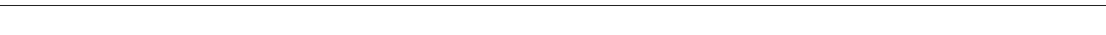
Fig. 3 MYC induces an alternative epigenetic program in mammary epithelial cells. a Barplot showing the distribution of MYC peaks on indicated genomic features in IMEC WT, IMEC-MYC, and M2. b Heatmap showing the dynamic behavior of MYC normalized ChIP-seq signals on MYC-bound TSS. Expression of annotated genes is reported. RPM reads per million. c Tag density plots of MYC normalized ChIP-seq signals in IMEC WT, IMEC-MYC, and M2, centered on up- (left) and downregulated (right) TSS. RPM reads per million. d GO of up- (upper panel) and downregulated (lower panel) genes bound by MYC on their TSS. e Identi fi cation of modulated enhancers among IMEC WT, IMEC-MYC, and M2. In the upper panel, the Venn diagram shows the overlap of H3K4me1 ChIP-seq peaks among different cell types. In the lower panel, identi fi ed H3K4me1-positive regions were analyzed for their enrichment in H3K27ac, leading to identi fi cation of modulated and unchanged enhancers in the reported comparisons. f Heatmap showing the dynamic behavior of H3K4me1, H3K27ac, and MYC normalized ChIP-seq signals overidenti fi ed modulated enhancers. Expression of associated genes is reported. Key relevant genes associated to different enhancers groups are indicated on the right. RPM reads per million. g TF binding motifs enrichment at enhancers activated in IMEC WT. h GO of genes associated to differentially modulated enhancers in IMEC WT and